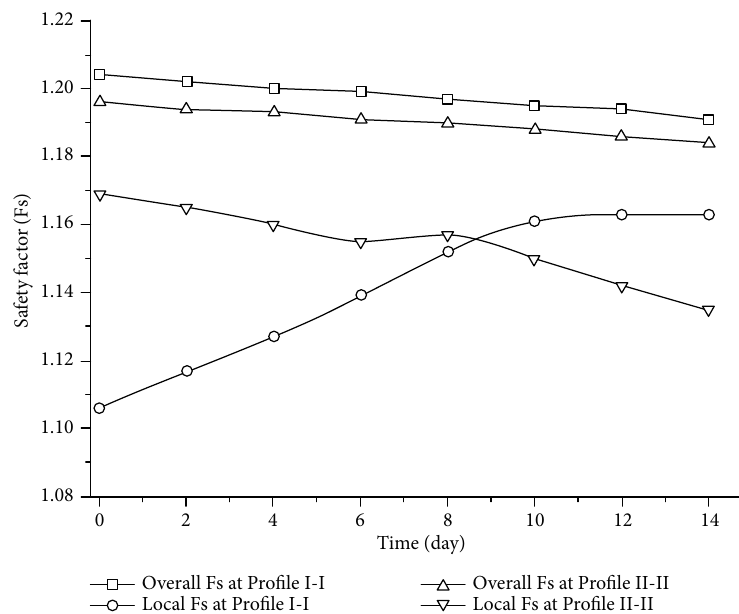
Figure 10: Safety factors of two pro fi les in fast impoundment condition.